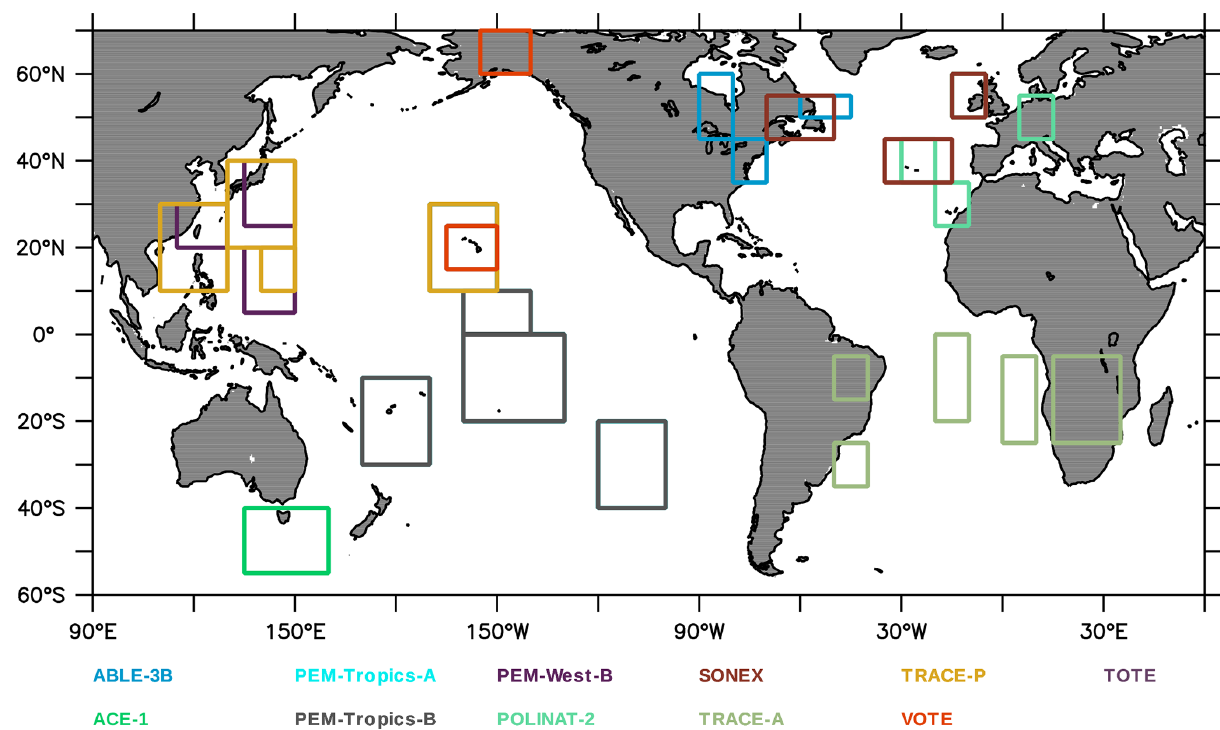
Figure 1. Geographical distribution of the aircraft campaigns presented by Emmons et al. (2000). Each field campaign is represented by a different colour. Further information on the campaigns is found in Emmons et al.